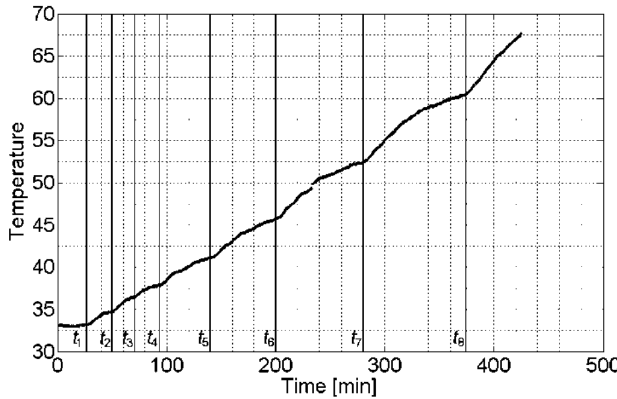
Figure 5. Temperature chart for the frequency 40 Hz and eight different values of the load